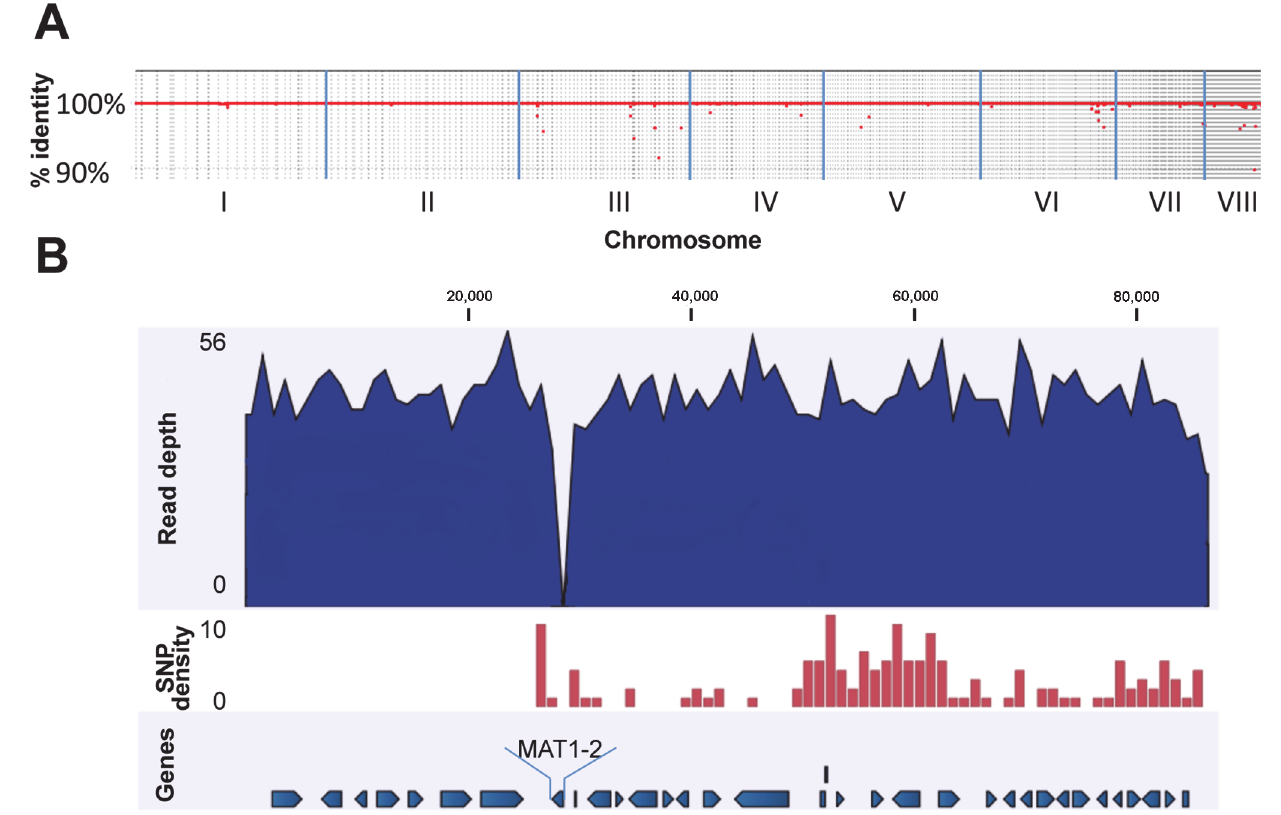
Fig 1. Genomic comparison of AFB62F9 and AFB62. (A) Whole genome coverage plot using AFB62F9 reads mapped to the AFB62 genome showing percent identity (y-axis) per chromosome (x-axis). The red line and dots represents regions of the AFB62 genome covered by AFB62F9 reads at greater than 90% identity. (B) Close-up of mapped reads to the region surrounding the MAT1-2 locus in AFB62. Numbers on top are coordinates on contig 677 (coordinates 1495670 – 1582078 on chromosome III). Top track in dark blue: average coverage of the genome was 48X with a maximum of 56 read coverage. The MAT1-2 locus in AFB62F9 had no mapped reads so the coverage drops to 0X (~27 Kb in this figure). Second track: SNP density per 1,000 bp is depicted as a red histogram. Maximum SNP/Kb was 10. Note the sharp increase surrounding the MAT1-1 locus and extending in the 3 ’ direction for an additional ~230Kb not depicted in this figure. Bottom track: annotated protein-coding genes in the AFB62 assembly. Direction of arrows depicts the coding strand.